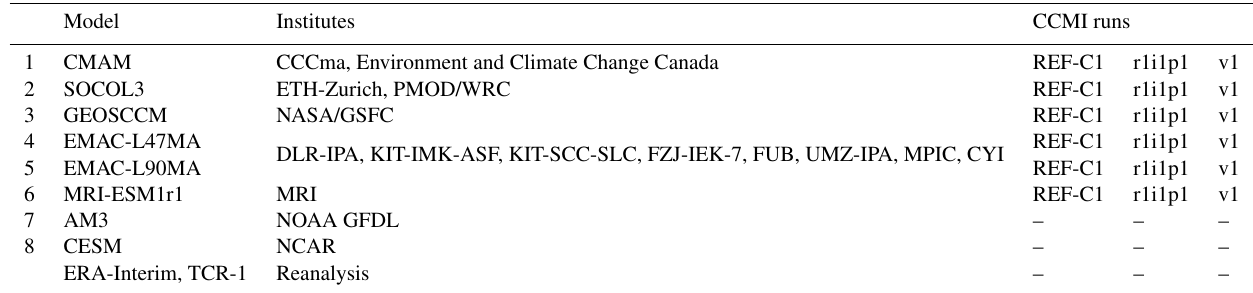
Table 1. The chemistry–climate models and their experiment simulations.